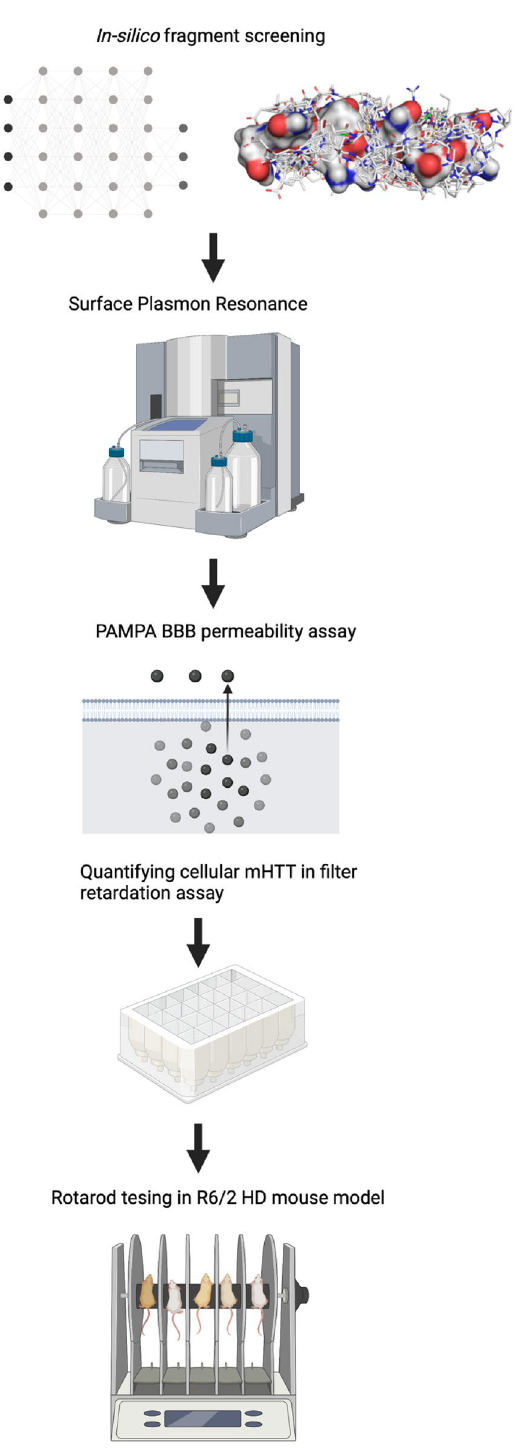
Figure 1. In the first step, we conducted an in-silico -based drug screening with a deep artificial neuronal network. Depicted are the selection of 67 small molecules docked on the surface of the polyQ tract peptide. 40 compounds were tested for their actual binding affinity to mutant huntingtin (mHTT) with Biacore, a system using surface plasmon resonance. Next, compounds were tested in an in-vitro mHTT assay and selected based on the ability of the compounds to lower mHTT and overcome an artificial blood–brain barrier in the PAMPA BBB permeability assay. Finally, we demonstrated in the R6/2 Huntington disease (HD) mouse model that the preclinical candidate GLYN122 can improve motor symptoms as measured with rotarod. Created with